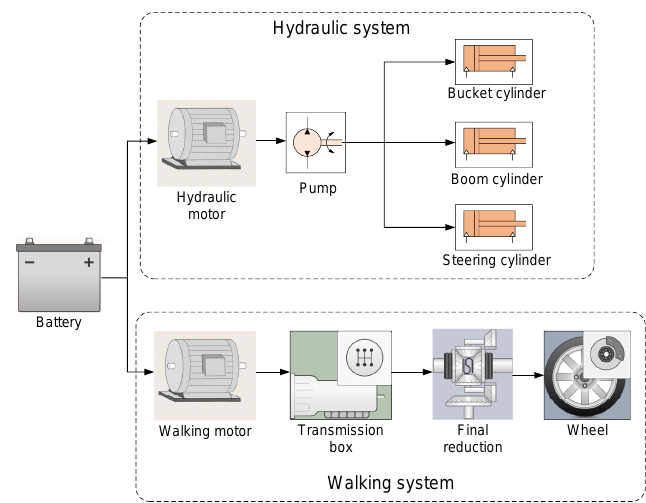
Figure 1. Power transmission routes for diesel-powered loaders.